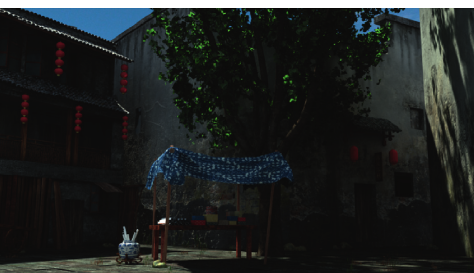
Figure 11: Completed unwrap chartlet.